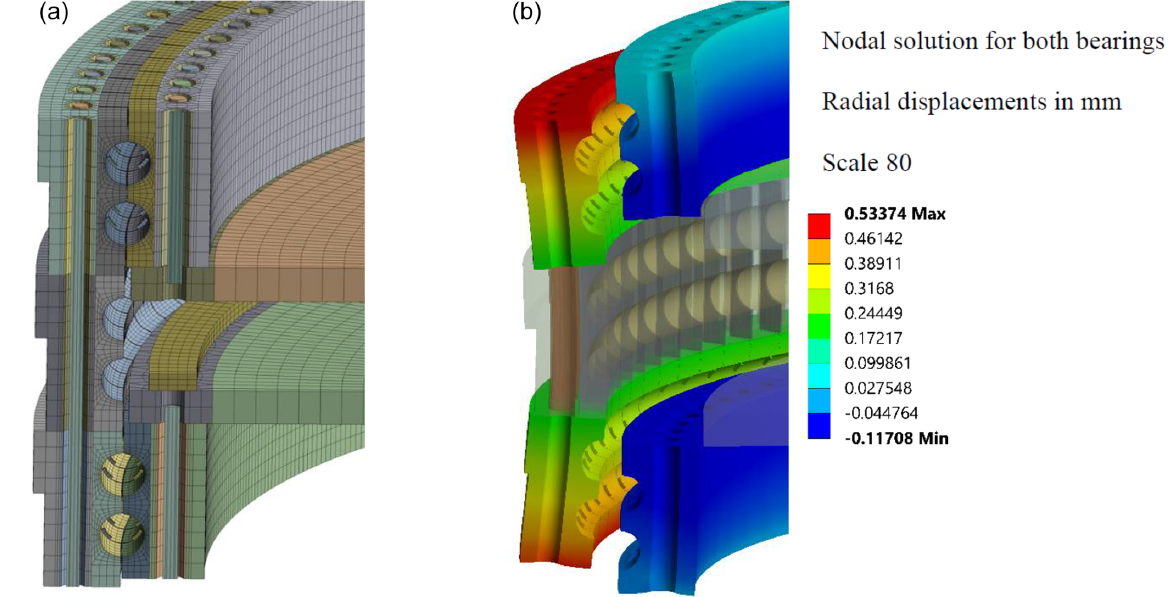
Figure 2. Cross-sectional view of the developed FE test rig model in an undeformed (a) and a deformed (b) state.